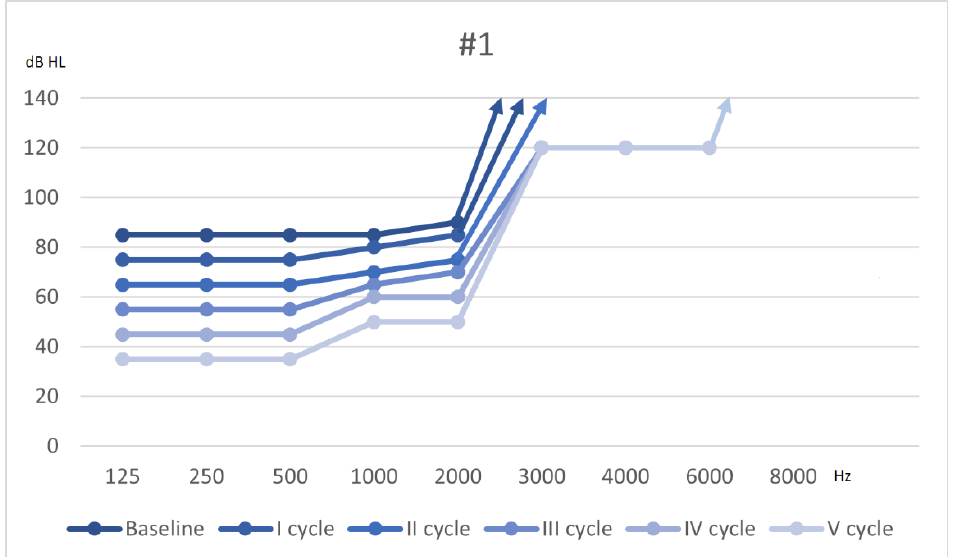
Figure 1. Hearing threshold at baseline, after 3 cycles of therapy and during the vestibular rehabilita- tion (IV and